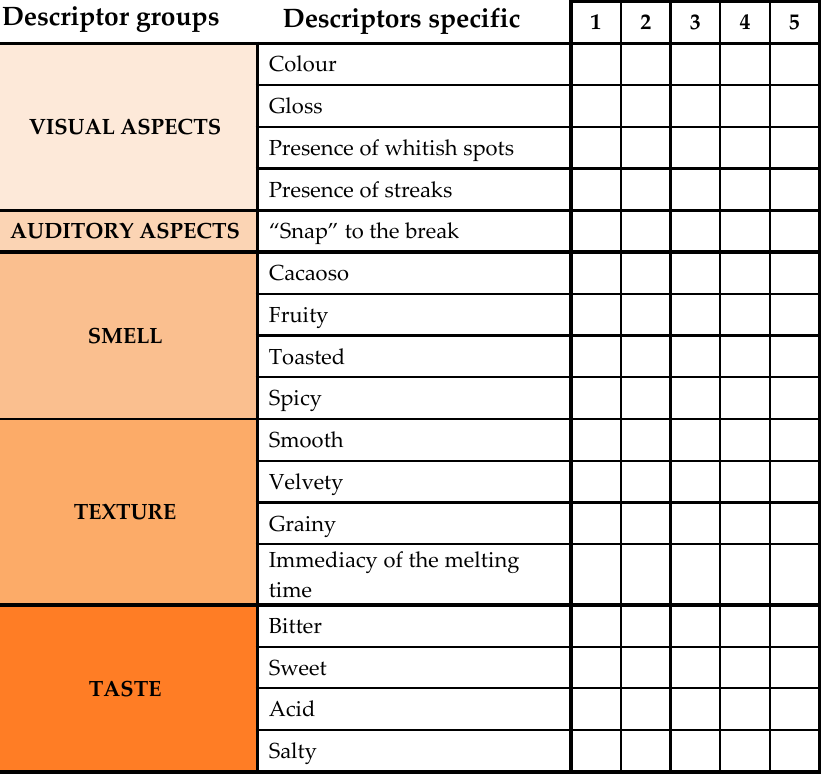
Figure 2. Forms employed for the organoleptic evaluation of the chocolates.